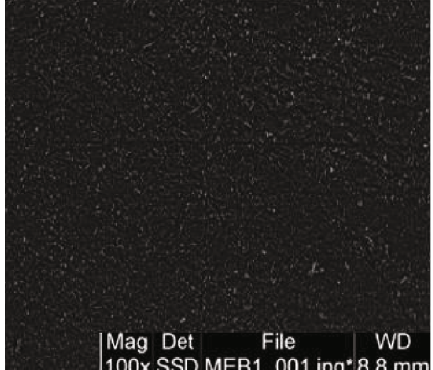
Figure 7: SEM images of the surface of the thin fi lm with 0.1wt%